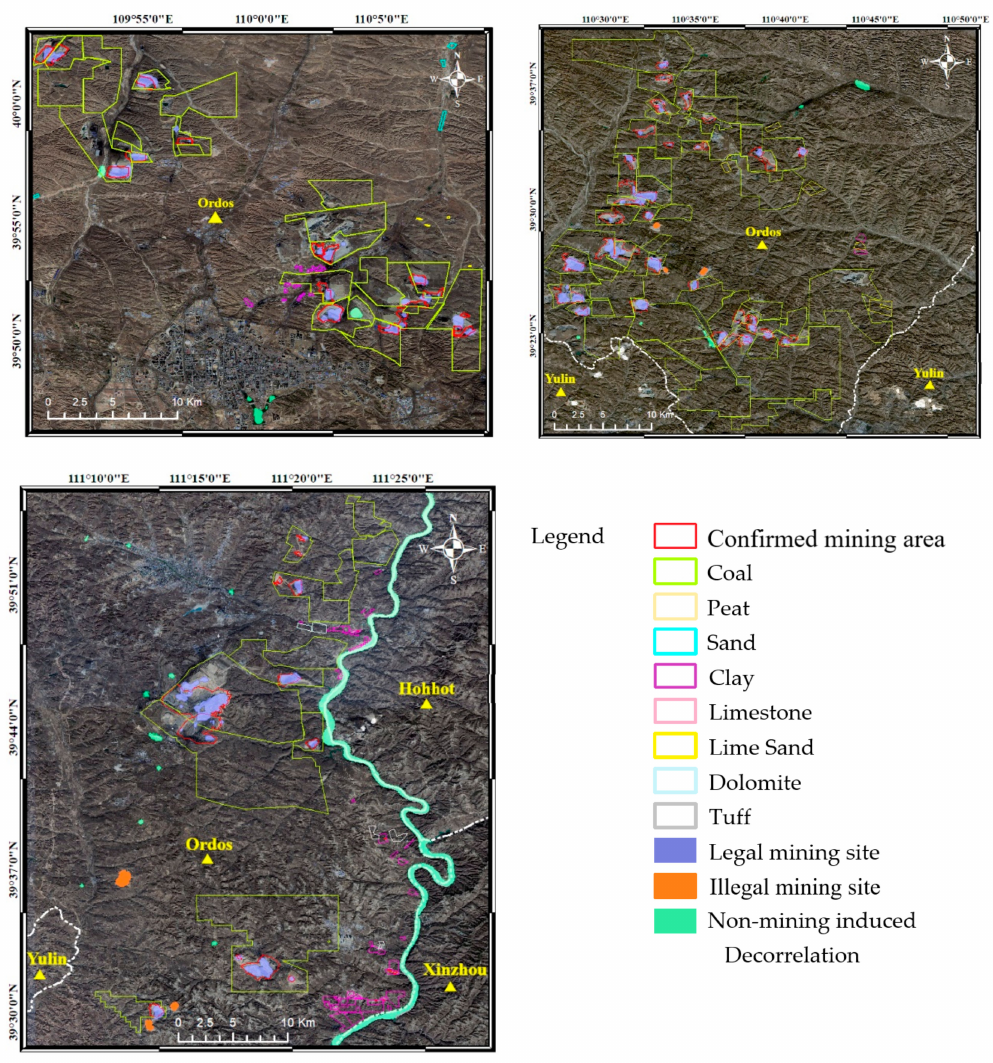
Figure 5. Illegal mining areas identification map for the three study areas overlaid with mining survey data indicating actual areas of